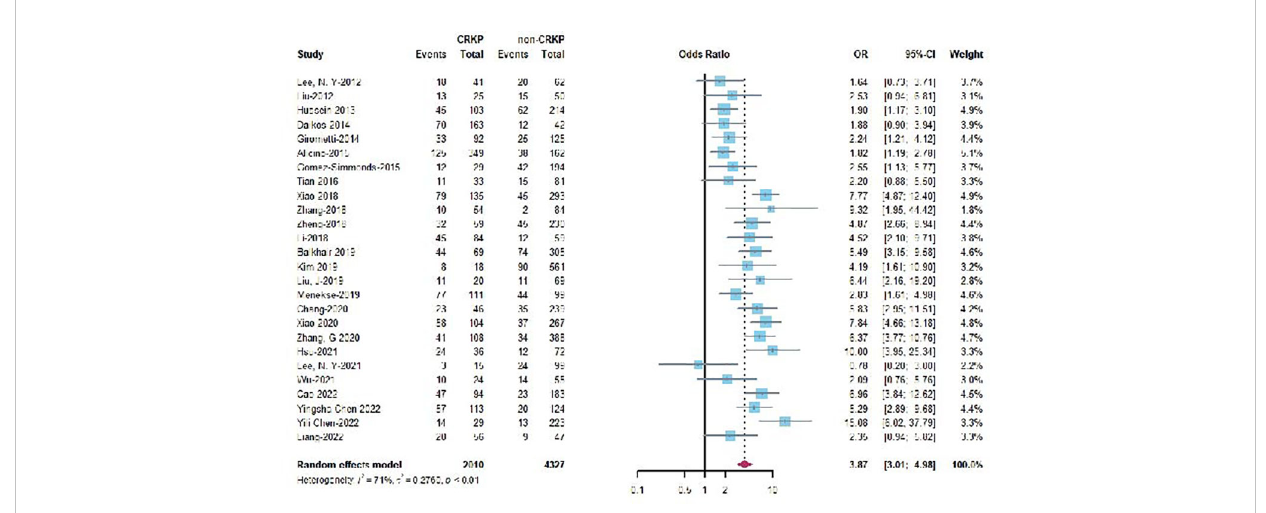
FIGURE 3 Forest plot of 30-day mortality for CRKP vs non-CRKP